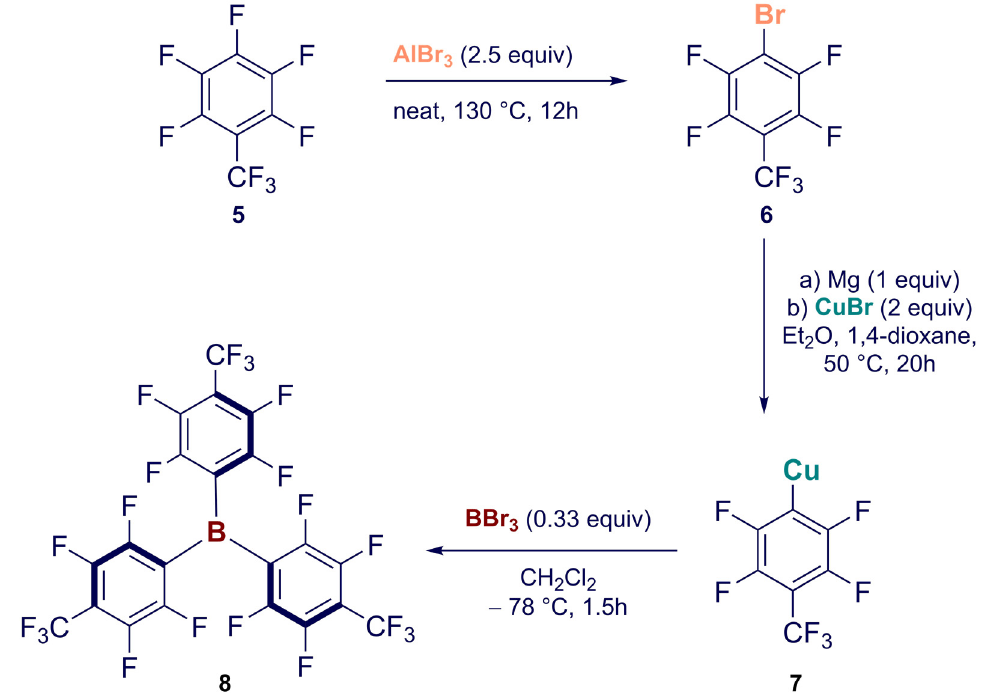
Scheme 2. Synthesis of the tris(perfluorotolyl)borane [B(4-(CF 3 )C 6 F 4 ) 3 ] 8 .